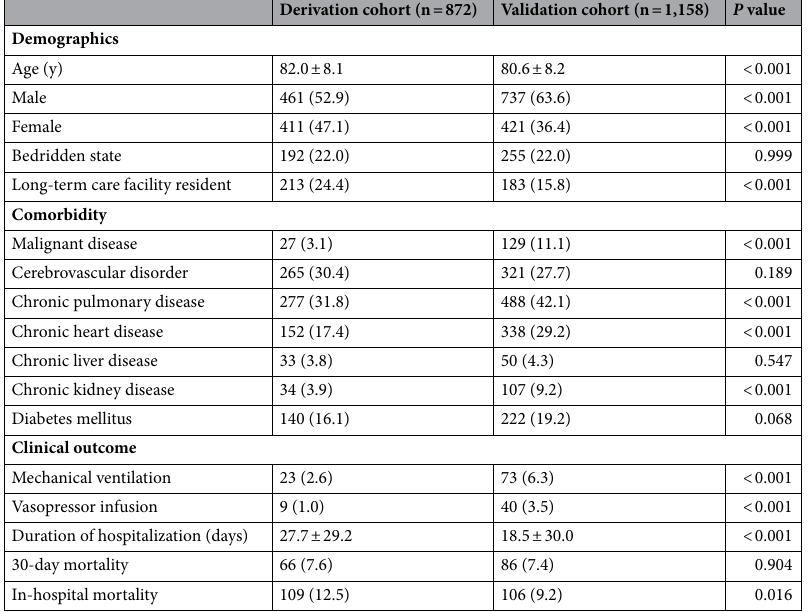
Table 1. Baseline characteristics of the patients. Data are presented as mean ± standard deviation or n